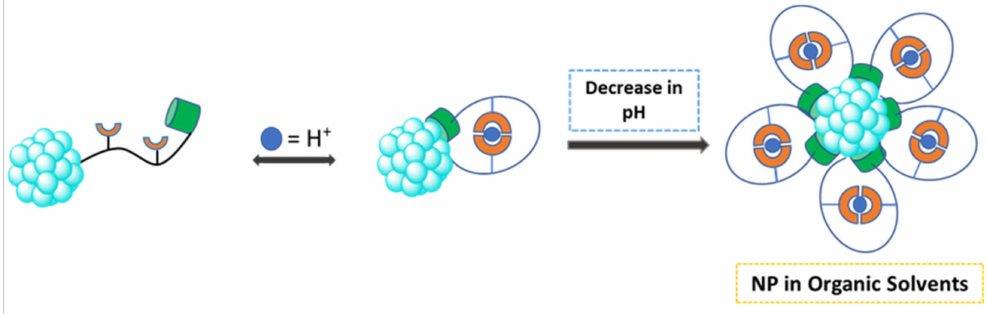
Figure 5. Schematic representation of phase transfer via pH modification [3]. In the figure, the abbreviation “NP” means